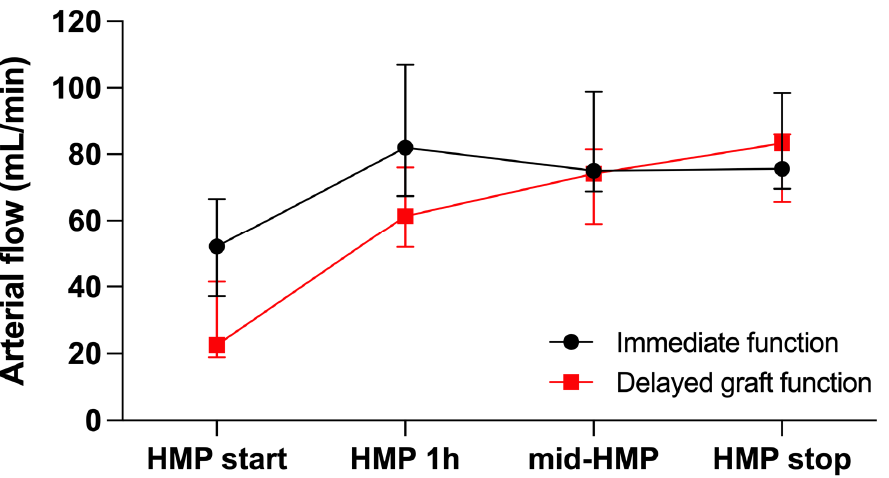
Figure 2. Arterial flow during hypothermic machine perfusion (HMP) according to graft function. Data are presented as median (interquartile range).